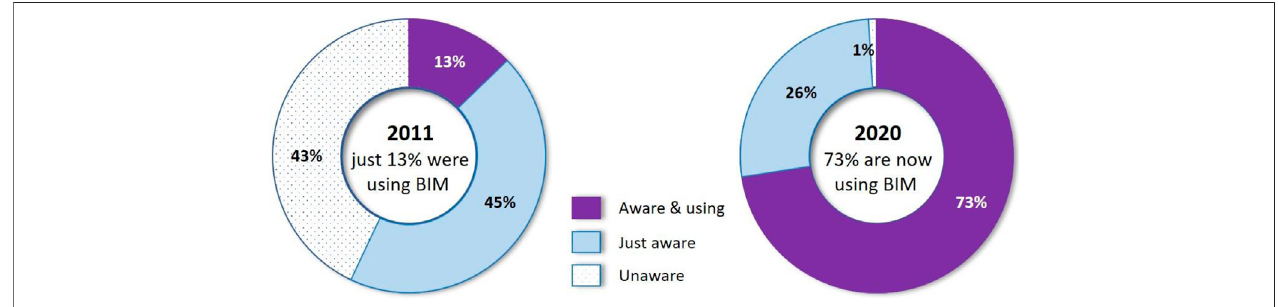
FIGURE 3 | BIM awareness and use — 2011 vs 2020. Adapted from NBS (2020), p. 16.